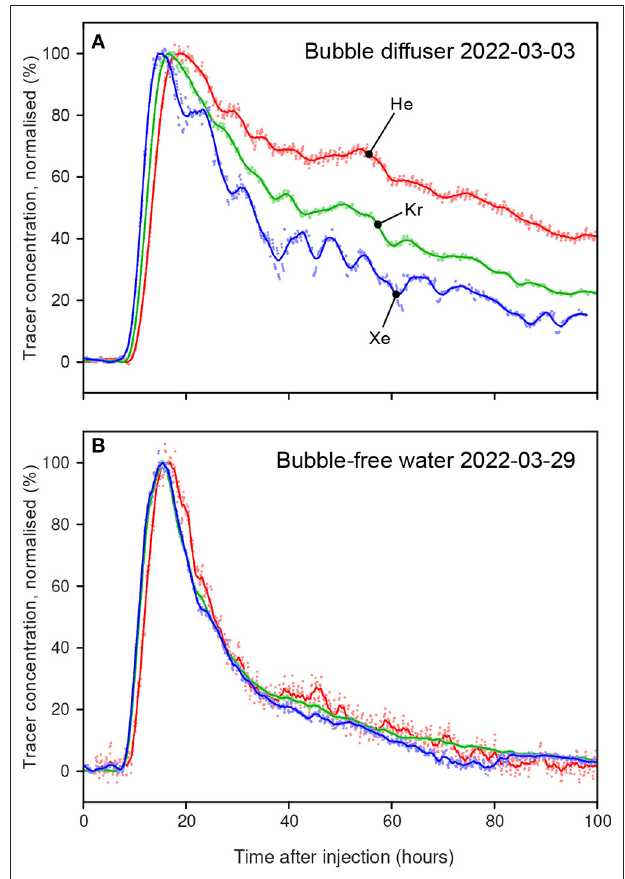
FIGURE 4 | Comparison of the breakthrough curves of combined He, Kr, and Xe injections at piezometer C. (A) Gas injection using the down-hole bubble diffuser on 2022-03-03. (B) Injection of dissolved gas spike in bubble-free water on 2022-03-29.